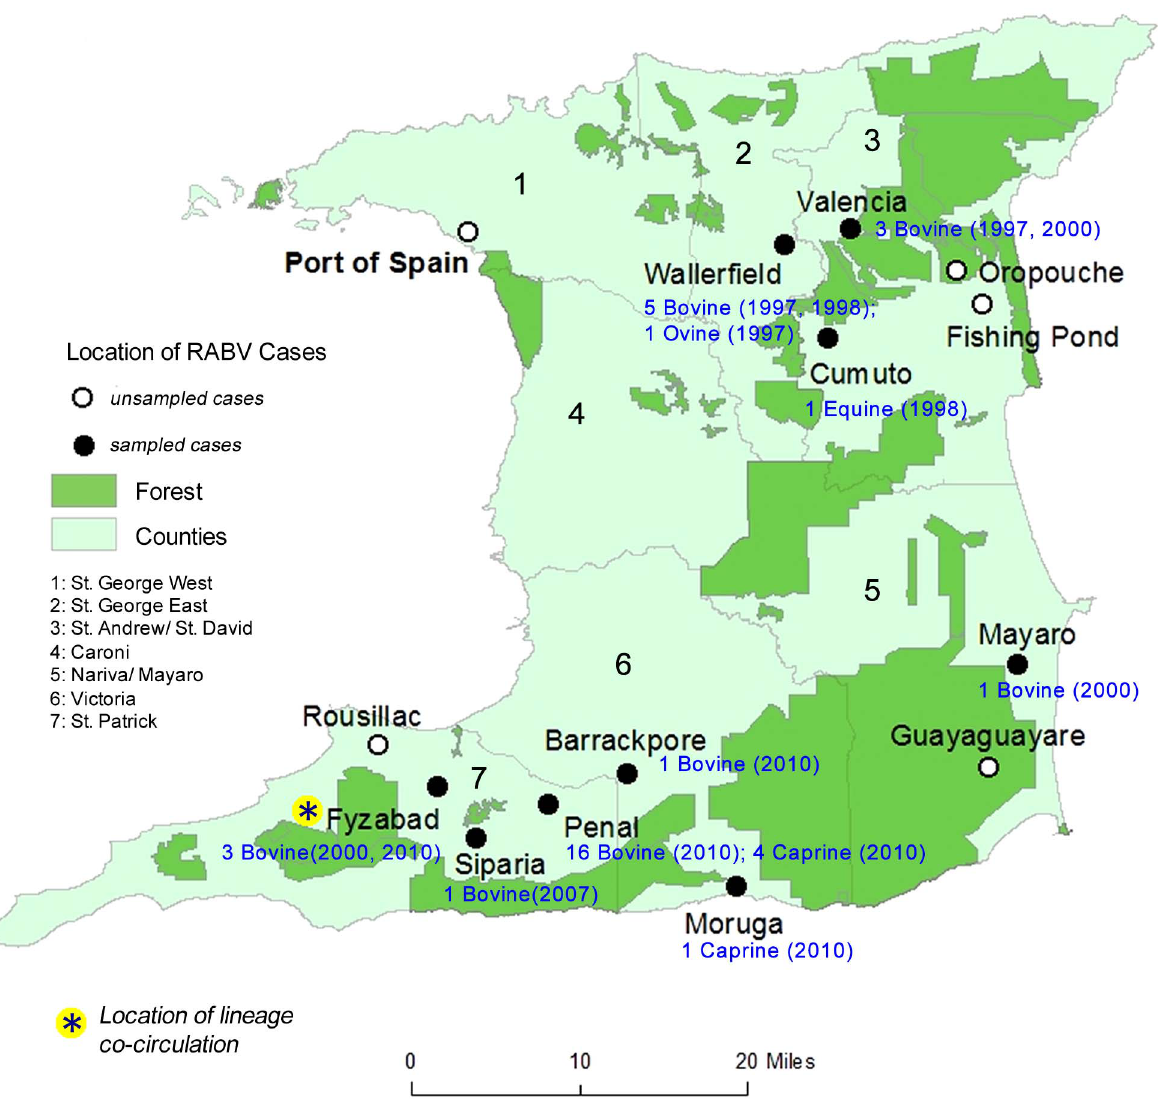
Figure 1. Geographical locations of confirmed RABV cases in Trinidad during the period 1997 to 2010. Locations of cases are indicated by circles, with black circles indicating locations from which RABV sequences were derived for the current study and white circles designating unsampled locations.. For sampled locations, the number of cases from which sequences were derived and their date and species of origin are indicated in blue. The location of co-circulation of Trinidad I and Trinidad IIa lineages is also indicated by an